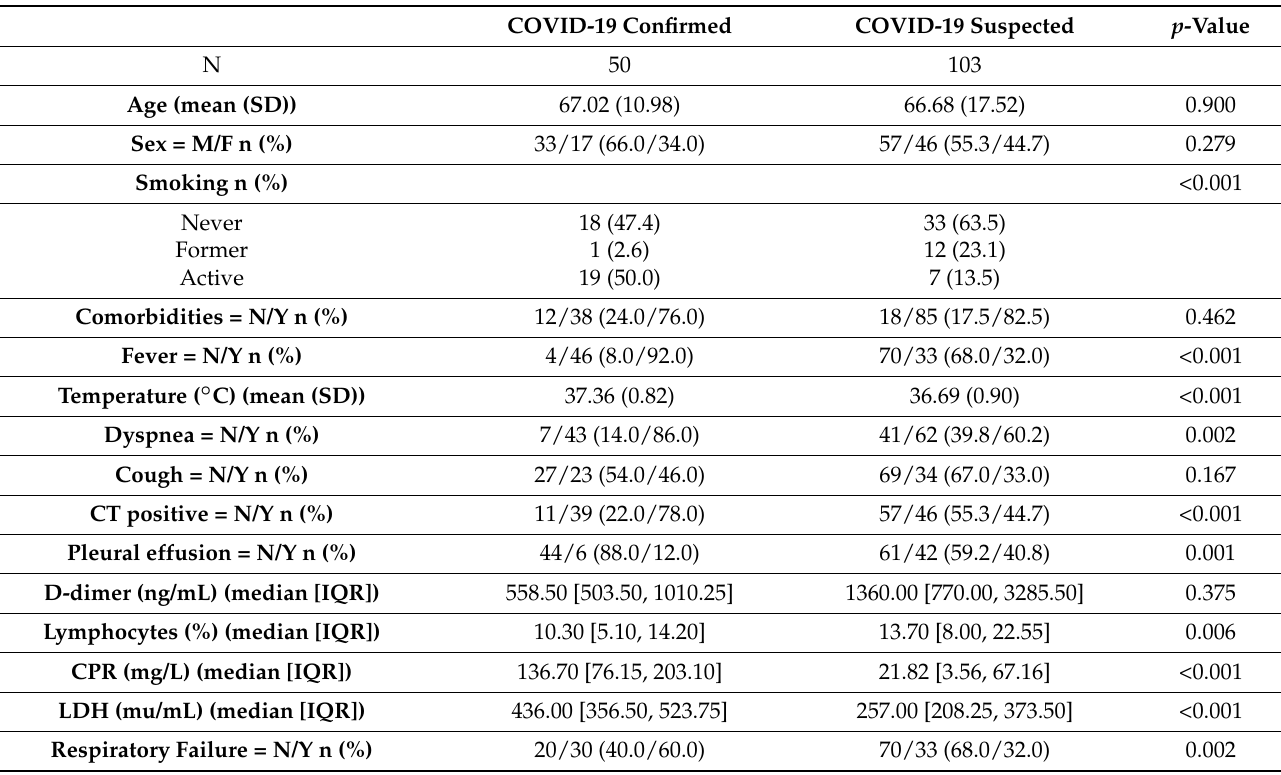
Table 1. General characteristics and comparison of the two study groups. CT: Computed Tomography; CPR: C-Reactive Protein; LDH: lactic dehydrogenase. Comorbidities are defined as any chronic disease or medical condition.